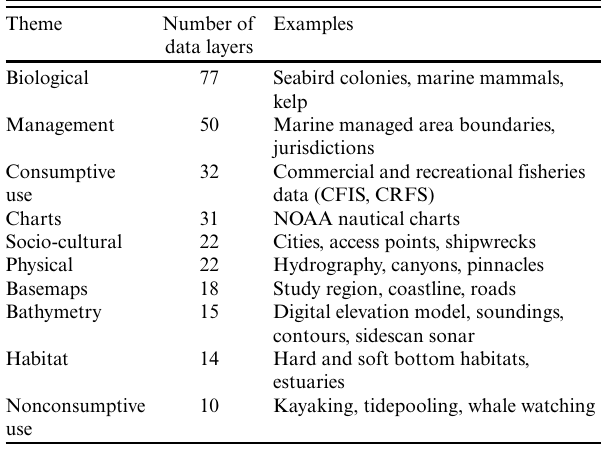
Table 1 . MarineMap data by theme. Organizations/Agencies: National Oceanic and Atmospheric Administration (NOAA); California Fisheries Information System (CFIS); California Recreational Fisheries Survey (CRFS). Adapted and reprinted from Ocean and Coastal Management 74, Merrifield et al., “MarineMap: A web-based platform for collaborative marine protected area planning,” pp 67-76, copyright 2013 with permission from